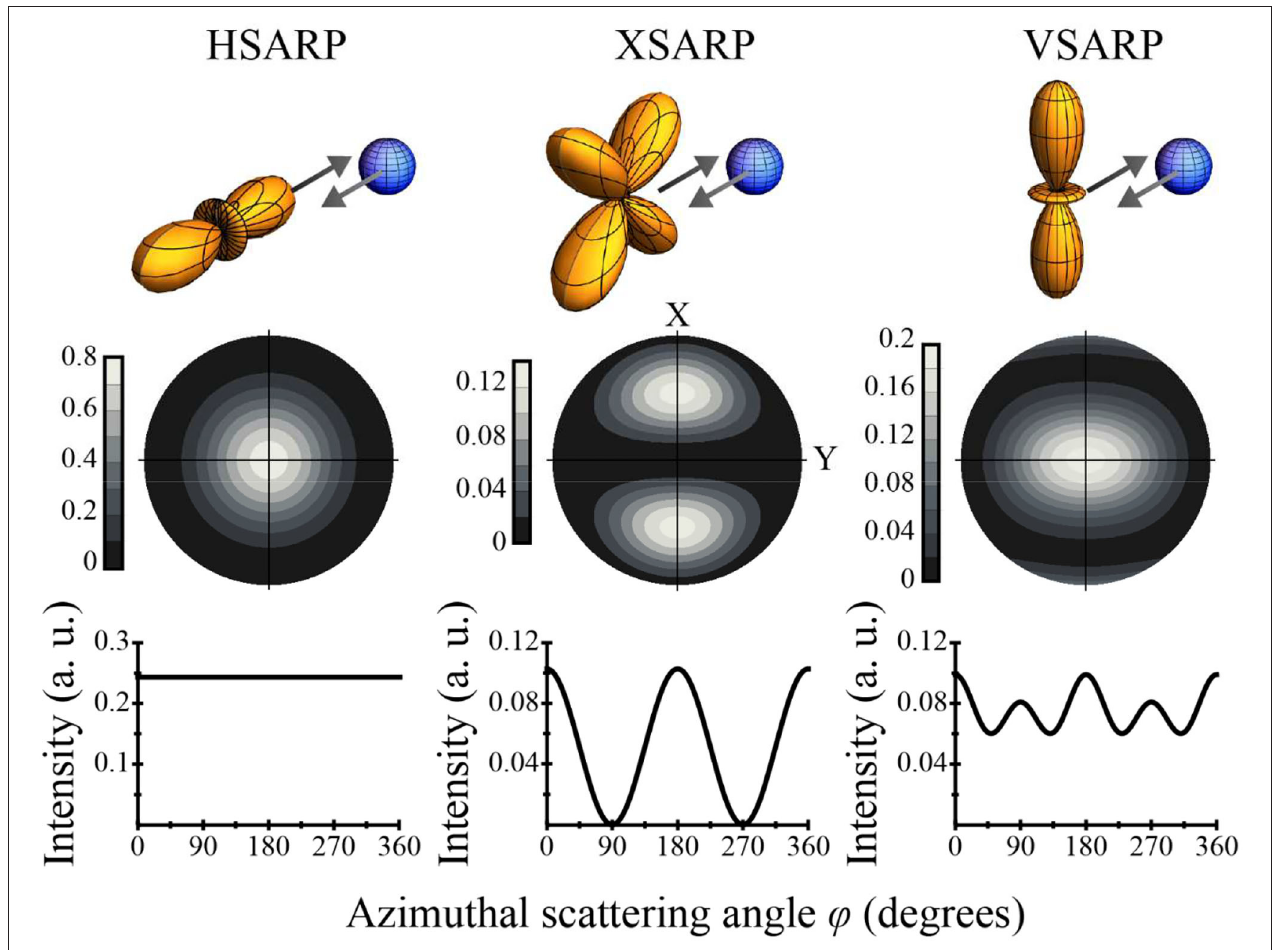
m 0 obtained with pump and Stokes polarizations given | i = m m 1 / 2) 0 3 / 8 2 . Here the plane of the page is | i + p | i − = = ±